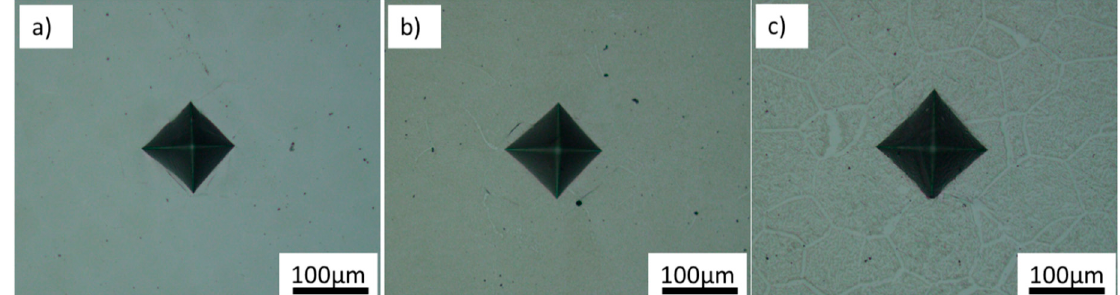
Figure 11. The hardness indentation images of Al 0.6 Si 0.3 : ( a ) as-cast ( b ) heat-treated at T = 800 °C and ( c ) heat-treated at T = 1000 °C.